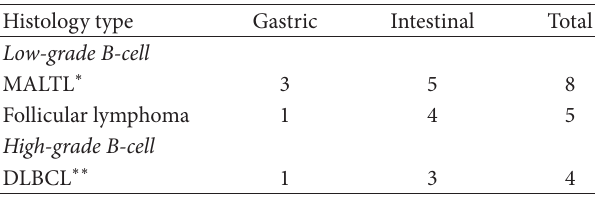
Table 2: Histological classification and sites of